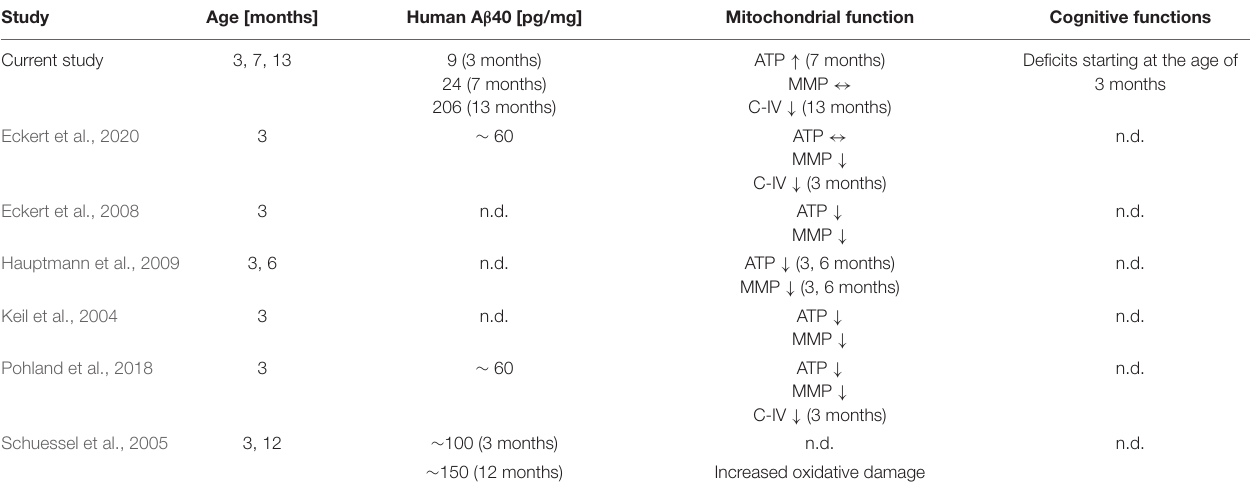
TABLE 4 | Results of studies that determined mitochondrial function in Thy1-APP 751 SL mice compared with the current longitudinal study focusing on amyloid levels in the brain; n.d. not